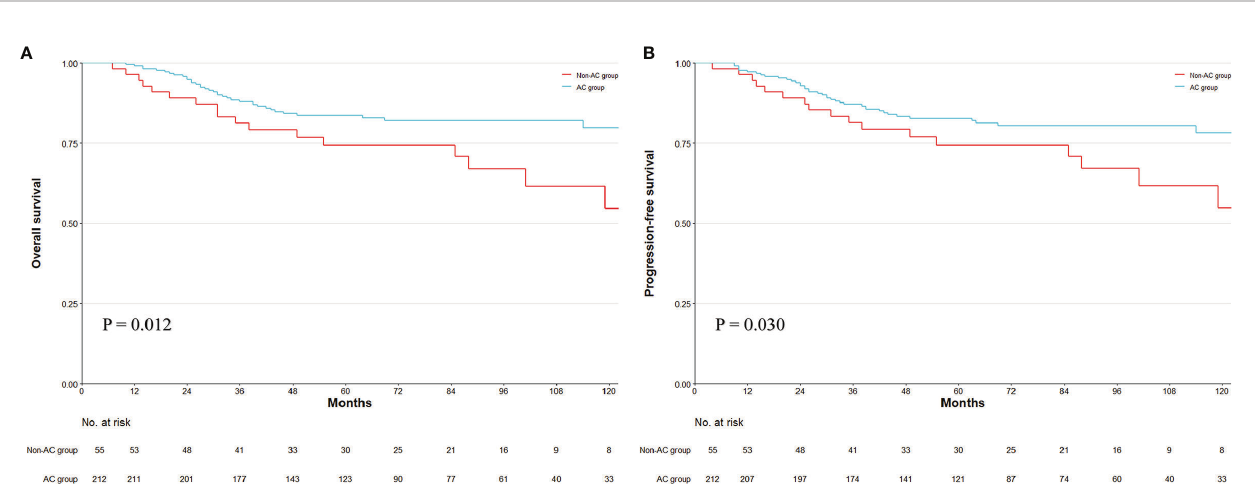
FIGURE 3 | Kaplan – Meier survival plot of overall survival (OS) and progression-free survival (PFS). The survival curve of OS and PFS in whole patients (A, B) . Numbers at bottom indicate patients at risk. p-value stands for log-rank